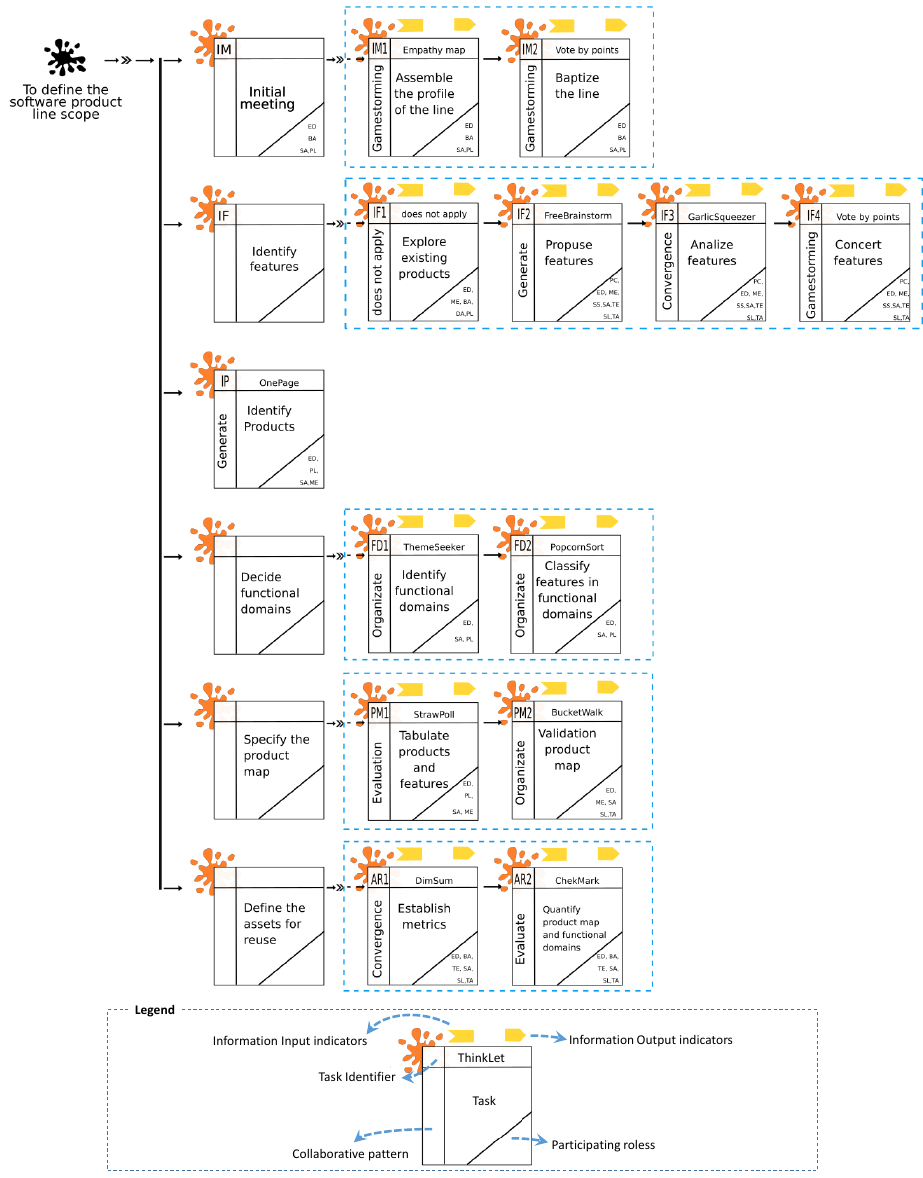
Figure 2. CoMeS-SPL (Collaborative Method for Scoping an SPL)